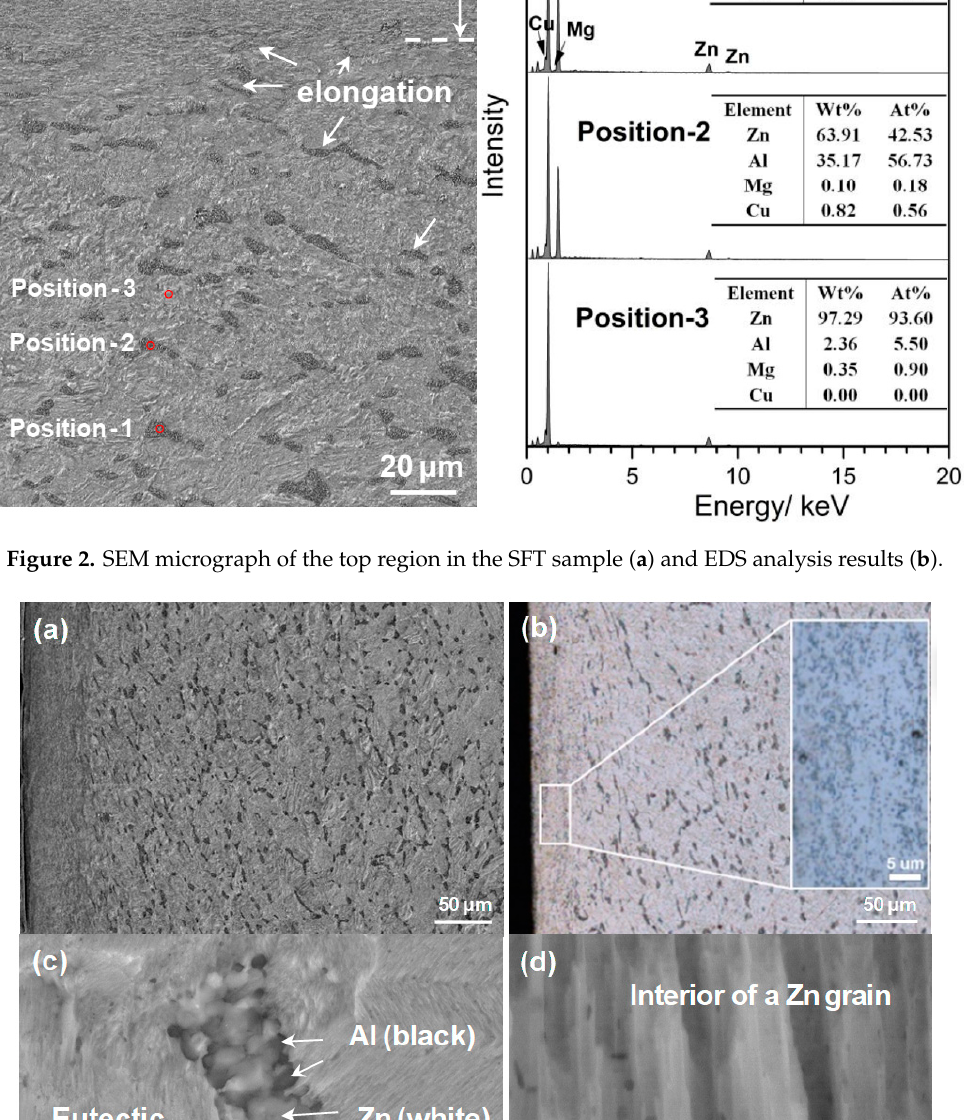
Figure 2. SEM micrograph of the top region in the SFT sample ( a ) and EDS analysis results ( b ).